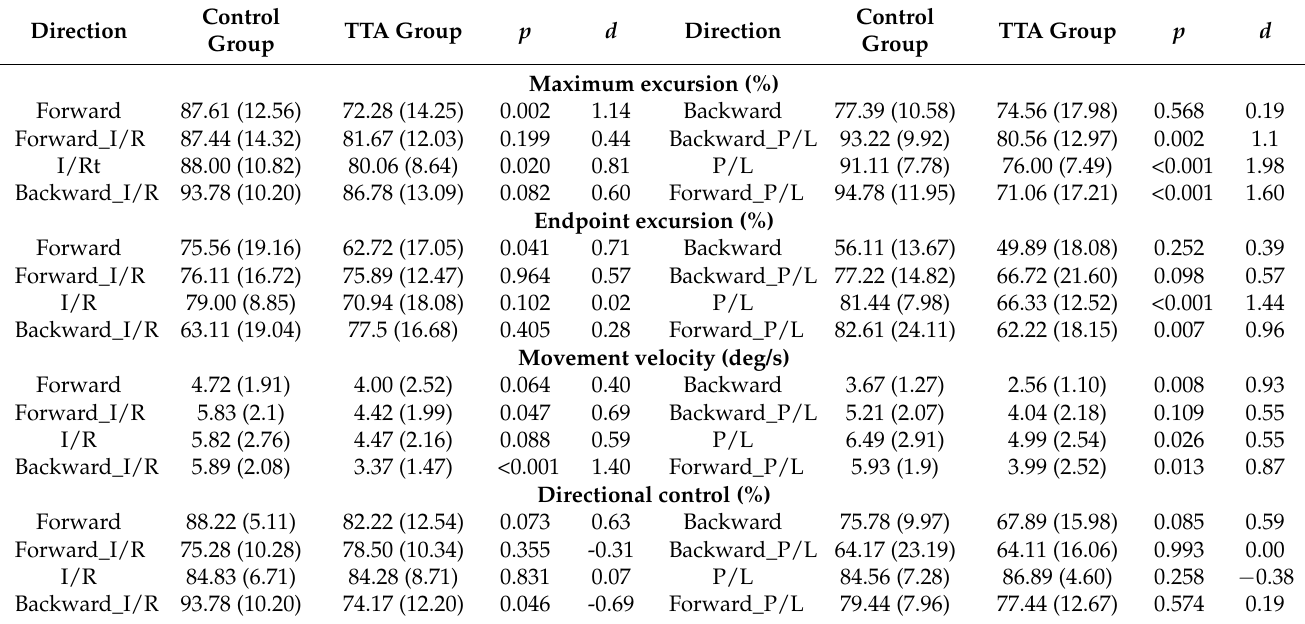
Table 3. Limits of Stability test